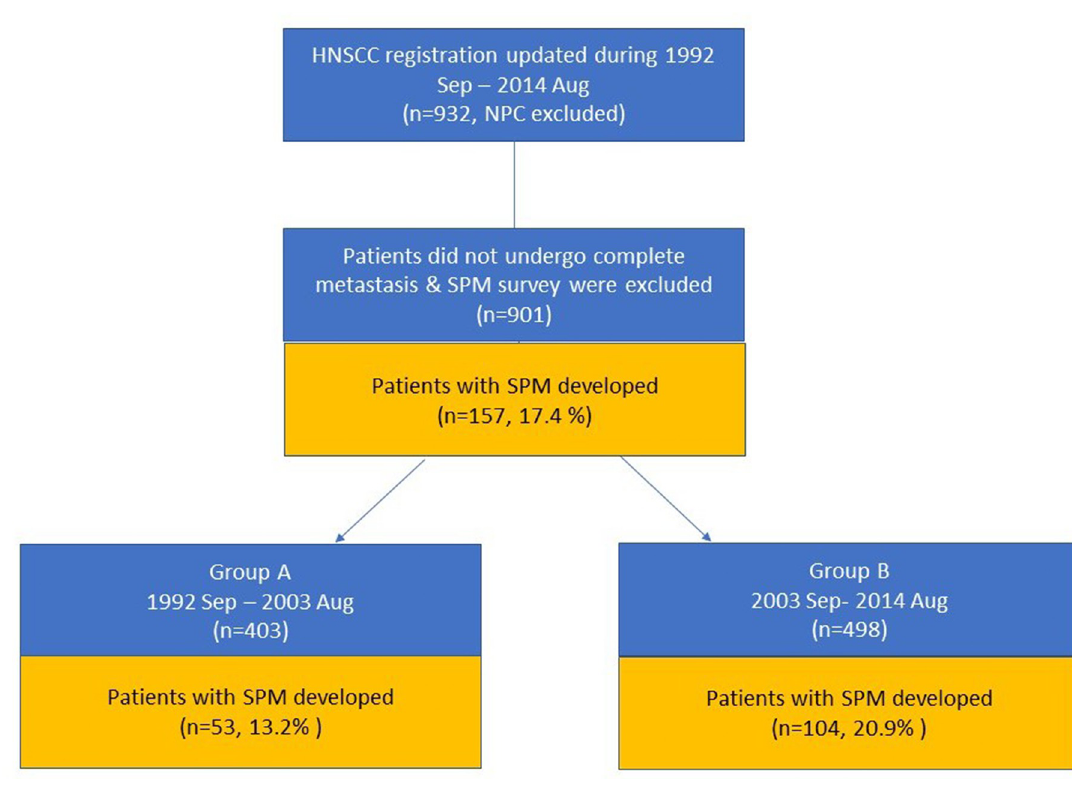
Fig 1. Flowchart of inclusion and exclusion procedure in each